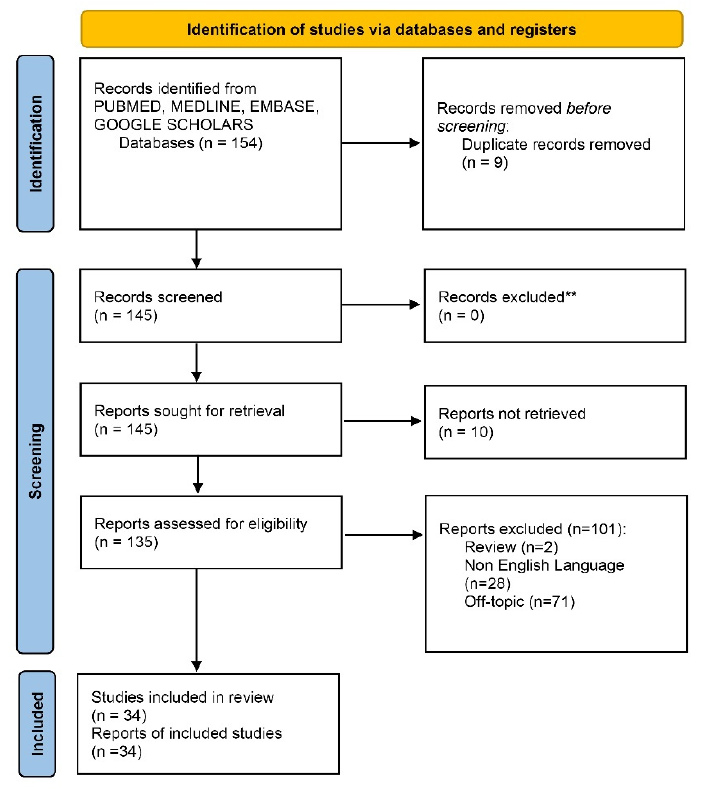
Figure 4. Prisma flowchart of the database search and study retrieval process.